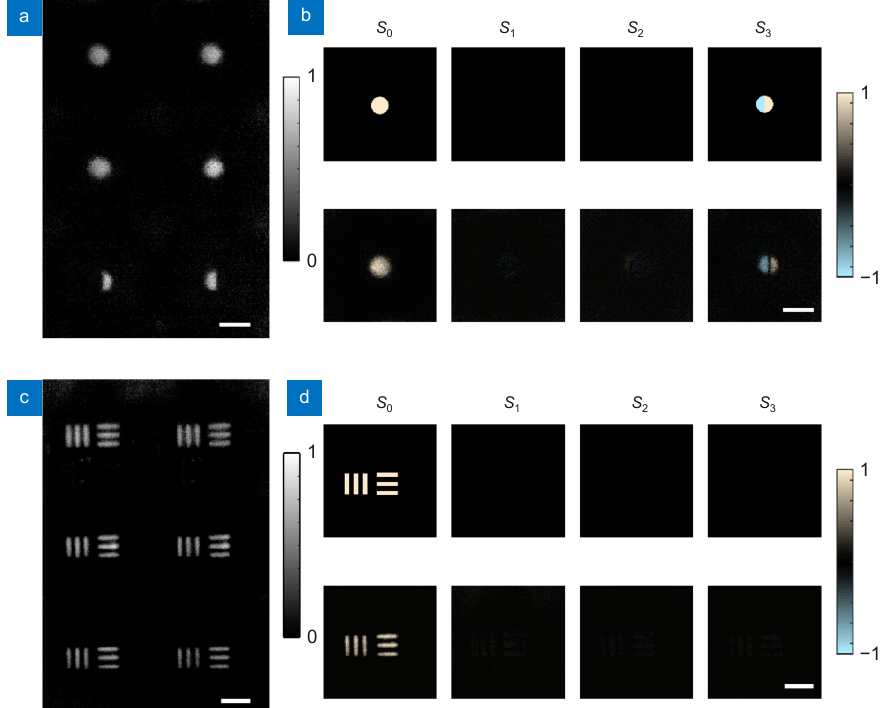
Fig. 7 | Polarization imaging. ( a ) Polarization imaging of the polarization mask. ( b ) Theoretical results (top) and experimental results (bottom) of Stokes parameters S 0 – S 3 corresponding to (a). ( c ) Polarization imaging of the resolution target. ( d ) Theoretical results (top) and experimental results (bottom) of Stokes parameters S 0 – S 3 corresponding to